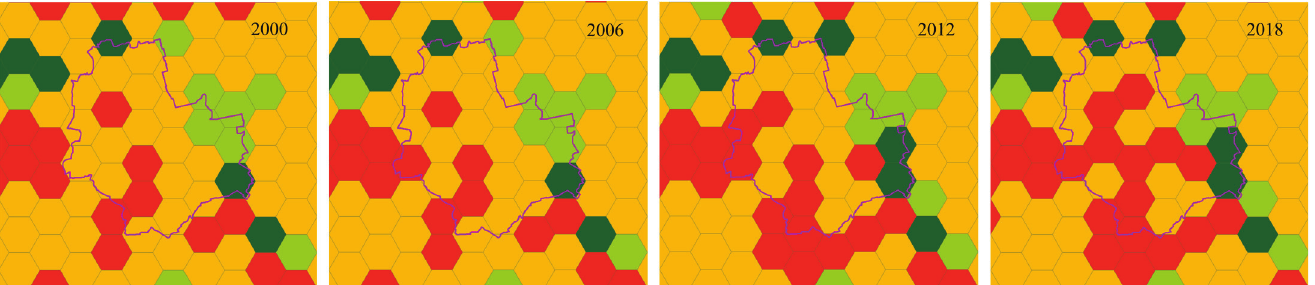
Figure 7. Changes in the classification of primary fields in Warsaw and the surrounding